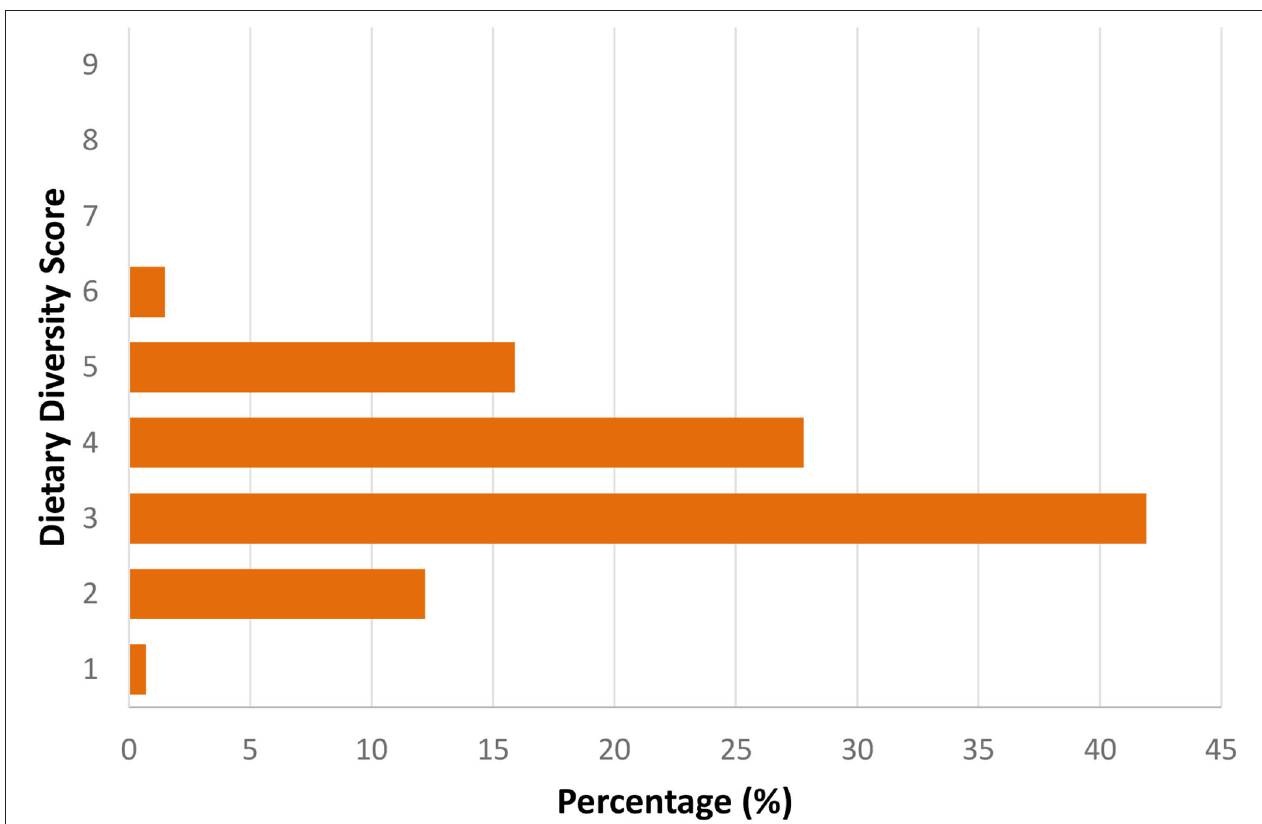
FIGURE 2 | Distribution of dietary diversity score (DDS) among sociology students of Caracas, 2016.